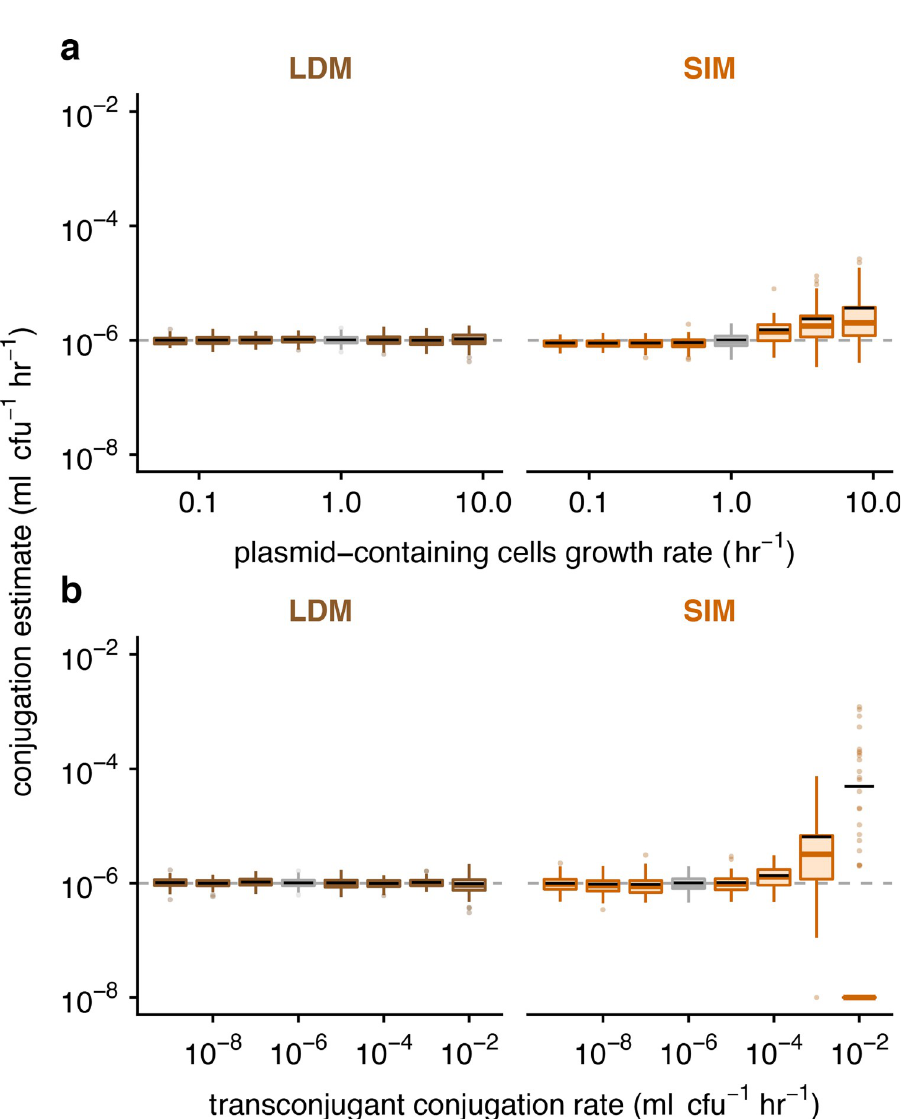
Fig 4. The effect of parametric heterogeneity on estimating conjugation rate. The Gillespie algorithm was used to simulate population dynamics. A total of 100 estimates of the donor conjugation rate are shown for each parameter (summarized using boxplots with the same graphical convention as in Fig 3). The gray dashed line indicates the true value for the donor conjugation rate (here, 10 − 6 ). The boxes in gray indicate the baseline parameter setting, and all colored boxes represent deviation of 1 or 2 parameters from baseline. The baseline parameter values were ψ D = ψ R = ψ T = 1 and γ = γ = 10 − 6 . The dynamic variables were initialized with D 0 = R 0 = 10 2 and T 0 = 0. All incubation times are D T short but are specific to each parameter setting (see Materials and methods and Table E in S1 File). (a) Unequal growth rates were explored over a range of growth rates for the plasmid-bearing strains, namely ψ D = ψ T 2 {0.0625, 0.125, 0.25, 0.5, 1, 2, 4, 8}. (b) Unequal conjugation rates were probed over a range of transconjugant conjugation rates, namely γ T 2 {10 − 9 , 10 − 8 , 10 − 7 , 10 − 6 , 10 − 5 , 10 − 4 , 10 − 3 , 10 − 2 }. For the 10 − 2 transconjugant conjugation rate, many of the runs resulted in SIM estimates of zero due to zero transconjugants at the specific incubation time; therefore, the median (colored line) and the box are placed at the bottom of the plot (given that the y-axis is on a log scale). The bulk of the data for this x-value is substantially lower than the mean SIM estimate (black line). The data and code needed to generate this figure can be found at https://github.com/livkosterlitz/LDM or https://doi.org/10.5281/zenodo.6677158. for screening combinations of incubation time and initial densities to select a target incubation time ( ~ t 0 ) as well as target initial densities ( D 0 and R 0 ) where 0 < ^ p ð ~ t Þ < 1 . Note we add 0 0 0 primes to indicate that these are “targets” to distinguish D , R , and ~ t in Eq 13, which will be 0 0